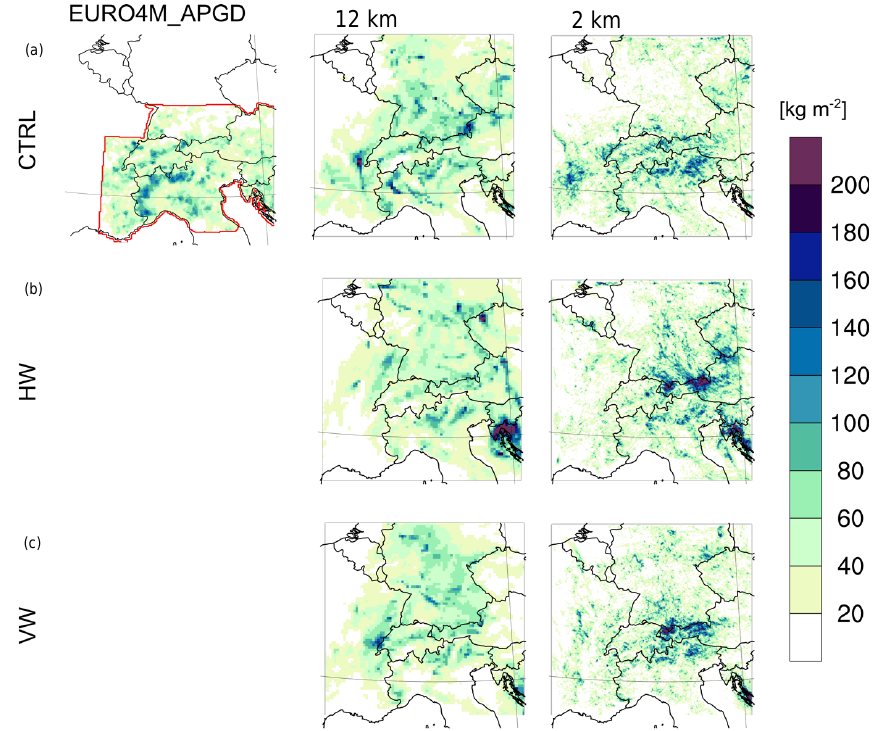
Figure 3. Total accumulated precipitation for 3–13 June 2007 over the analysis domain for observations of EURO4M-APGD and six sim- ulations. The area with observations is smaller than the model domain and the border is indicated in red. Panel (a) shows observations and two simulations for the present climate (CTRL), (b) shows the two HW simulations, and (c) shows the two VW simulations.